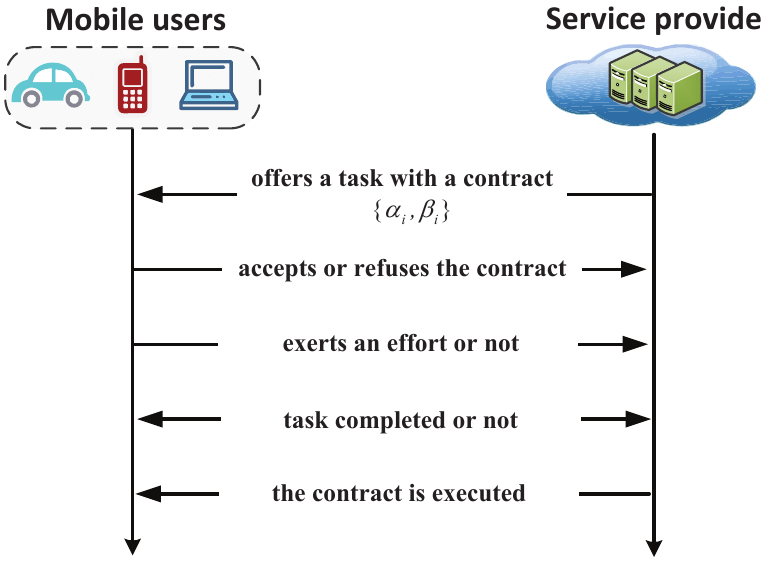
Figure 2. Contract-based incentive mechanism for mobile